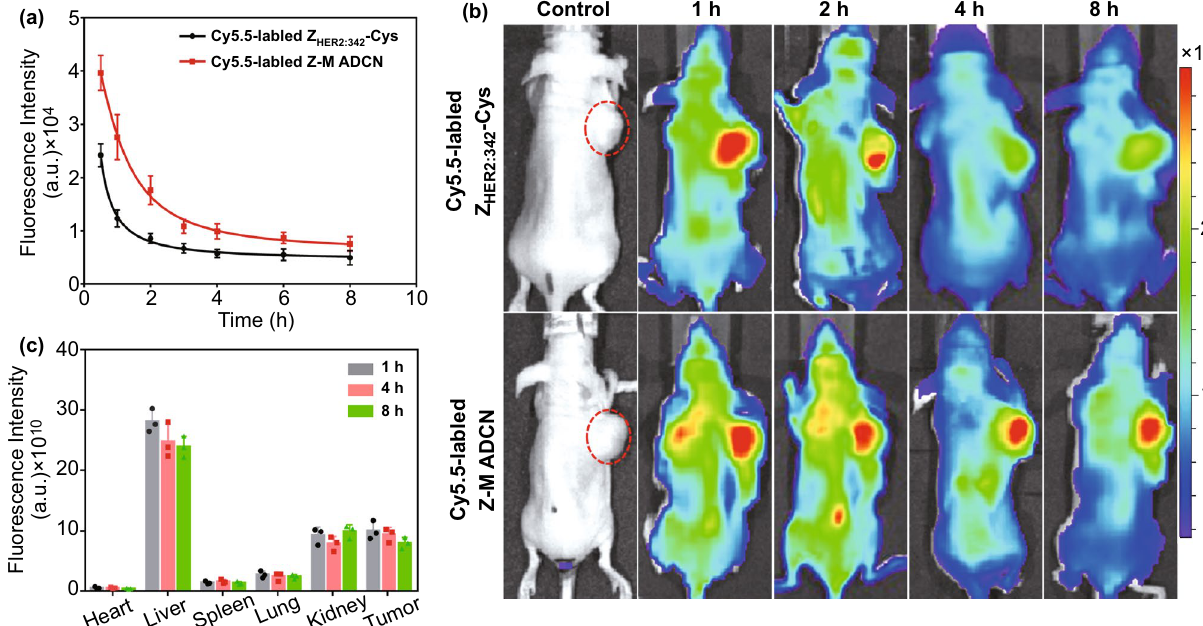
Fig. 4 The biodistribution of Z-M ADCN in the SKOV-3 xenograft-bearing mice. a Representative concentration in plasma versus time pro- files of Cy5.5-labeled Z HER2:342 -Cys and Cy5.5-labeled Z-M ADCN after i.v. injection into SD rats. Data are presented as the mean ± s.d. ( n = 4 mice). b In vivo imaging of the mice administered with Cy5.5-labeled Z HER2:342 -Cys, Cy5.5-labeled Z-M ADCN at 1 h, 2 h, 4 h, and 8 h post- injection. The red dotted cycles indicate the sites of tumors. c Quantitative analysis of biodistribution in different tissues at 1 h, 4 h and 8 h post- injection of Cy5.5-labeled Z-M ADCN. Data are presented as the mean ± s.d. ( n = 3